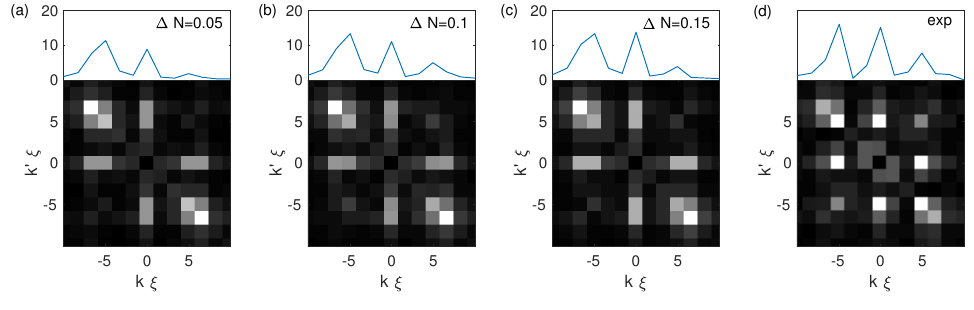
Figure 6: 2D wavevector spectra for the correlations in Figs. 5. Panels (a-c): ∆ N / ¯ N = 0.05,0.1,0.15, respectively. Bottom: 2D wavevector spectrum; top: cut-through of the 2D spectrum at k (cid:48) ξ = 5. Panel (d): 2D wavevector spectrum of the experimental corre- lation; upper panel is its cut-through at k (cid:48) ξ =